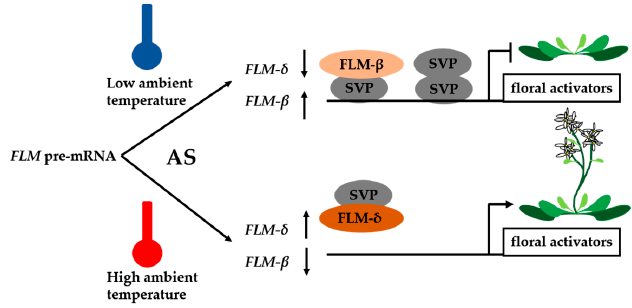
Figure 1. Model of the temperature-dependent FLOWERING LOCUS M ( FLM ) function. At low temperature, SHORT VEGETATIVE PHASE (SVP) can form homodimer or interact with FLM- β